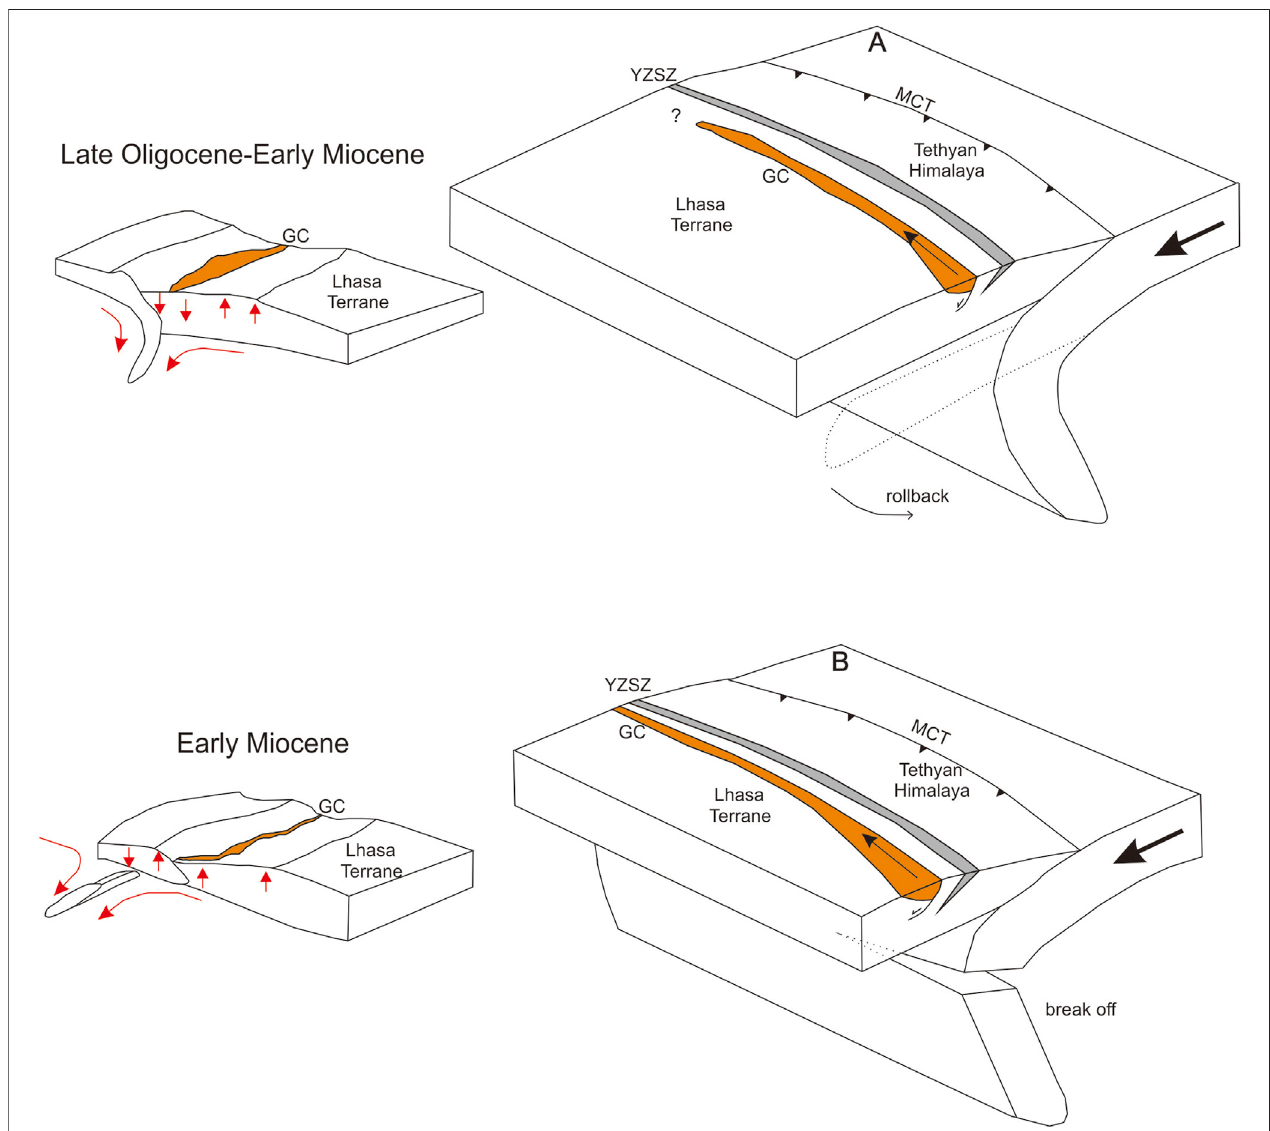
FIGURE 9 | Sedimentary-tectonic model of upper Oligocene – lower Miocene Gangdese conglomerate along Yarlung-Zangbo suture zone (modi fi ed after Leary et al., 2016). MCT: Main Central Thrust; YZSZ: Yarlung-Zangbo suture zone; GC: Gangdese conglomerate.